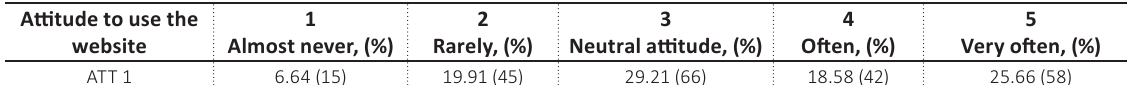
Source: Own elaboration.